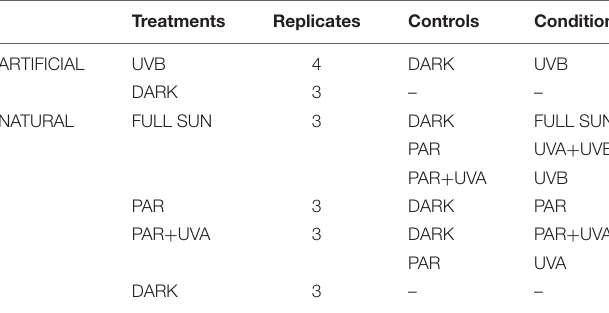
TABLE 1 | List of the analyzed conditions (artificial UVB, natural Full Sun, natural PAR, natural PAR + UVA, natural UVA + UVB, natural UVB, natural UVA), obtained by comparing different treatments and